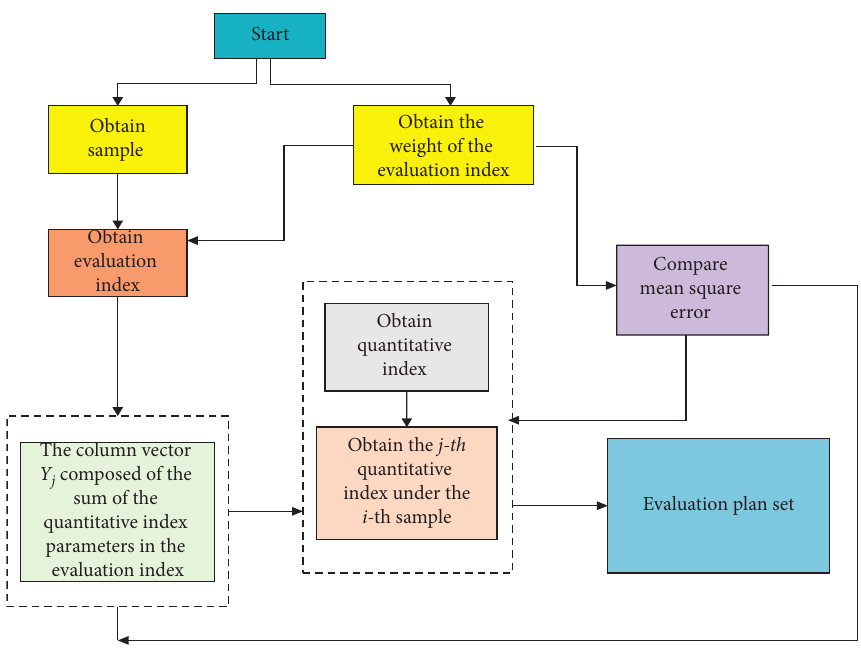
Figure 2: Quantitative evaluation algorithm for teacher informatization